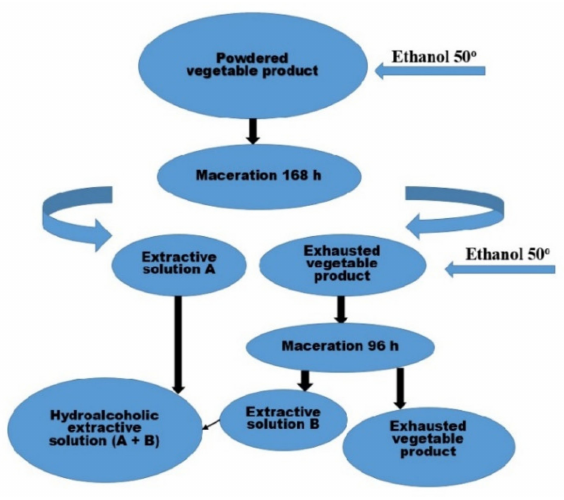
Figure 1. The extraction process for the CILTAG